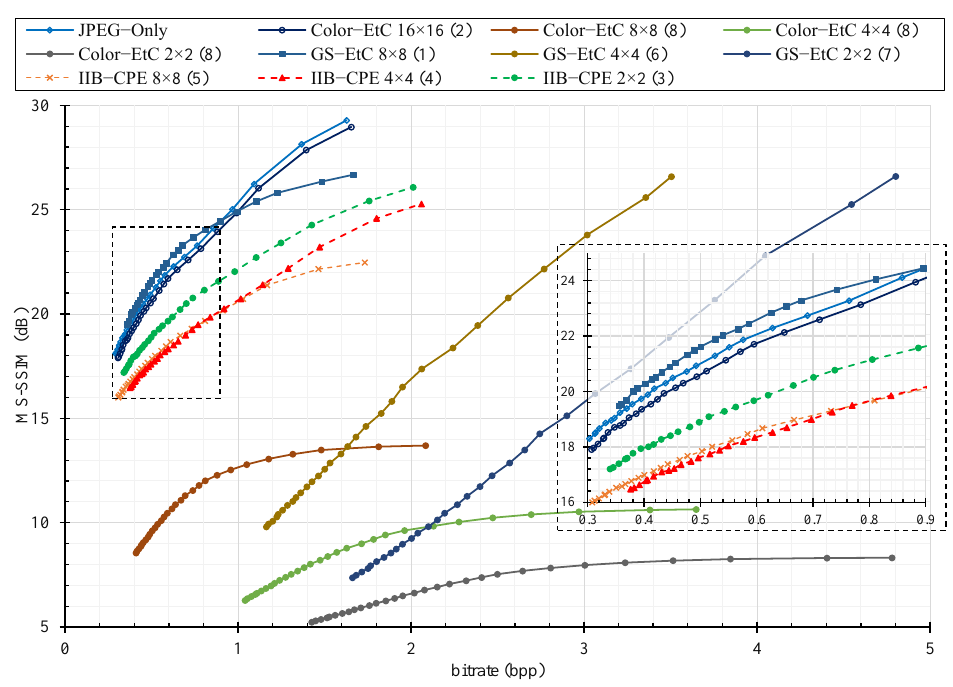
Figure 7. The JPEG compression performance with chroma subsampling ratio (4:2:0) on different perceptual encryption methods in terms of rate distortion (RD) curves with respect to MS–SSIM (dB) on Tecnick color dataset. The number enclosed in parentheses at the end of each series name shows its performance rank. The overlapping regions in the graph are zoomed in and shown in the bottom right corner.